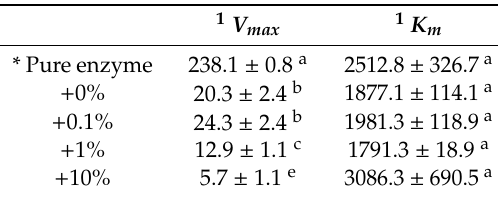
Table 1. The e ff ect of montmorillonite addition to soil on the kinetic parameters ( V max and K m ) of α -glucosidase (AG) obtained in the enzyme–clay mixture. V max is expressed in µ mol g − 1 h − 1 (* µ molh − 1 ). K m values are provided in µ